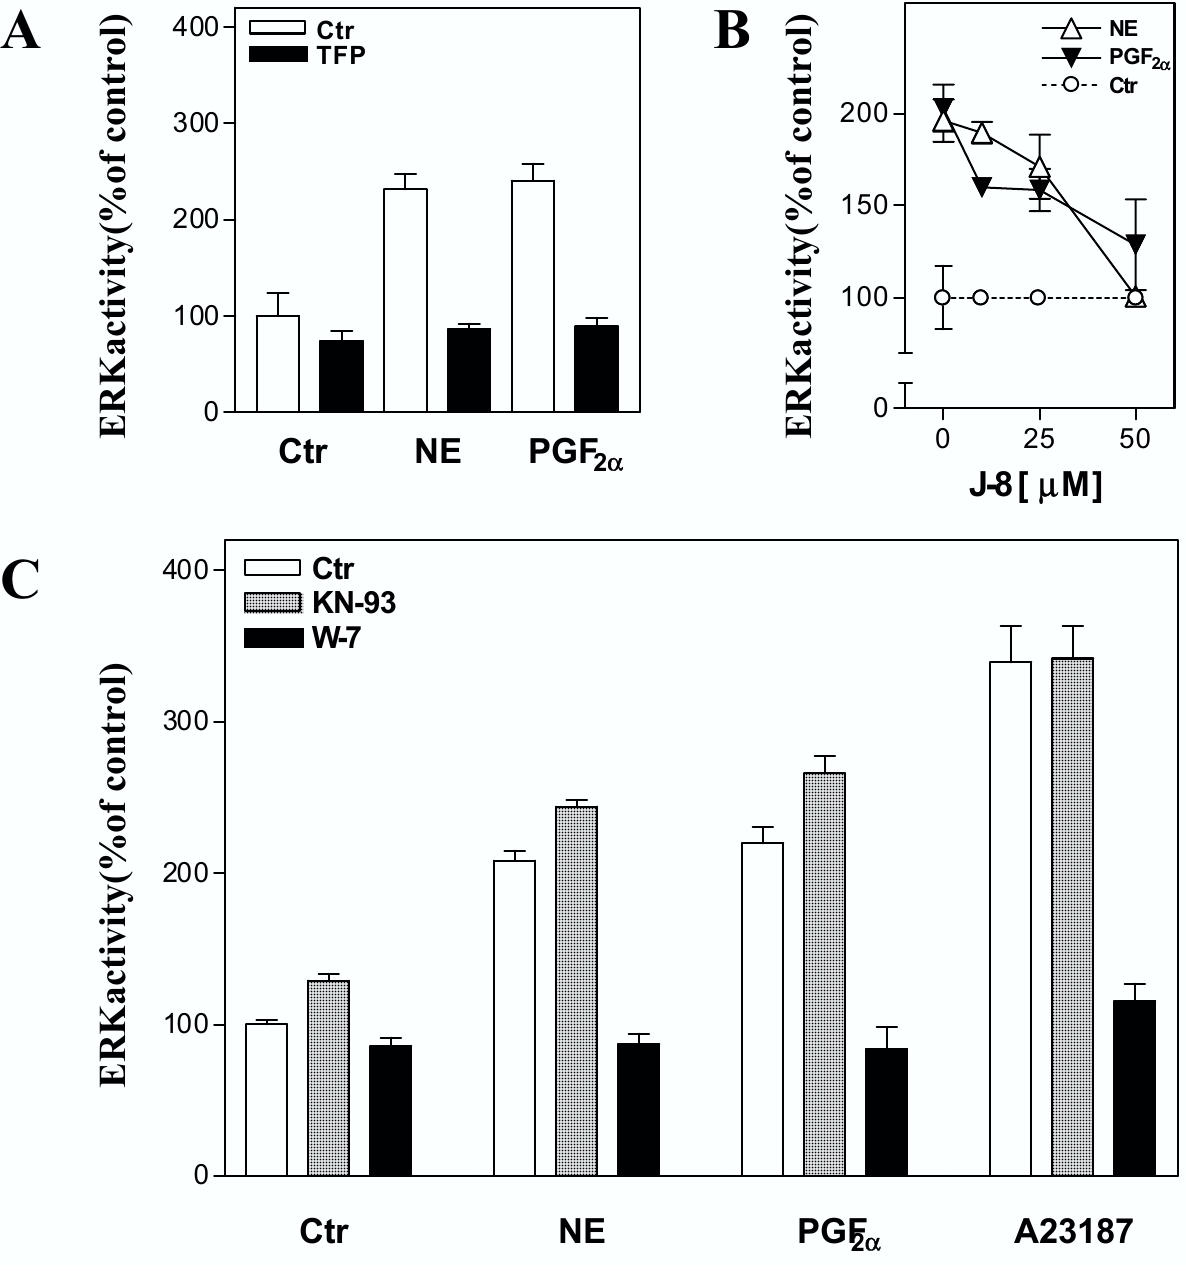
Figure 5 Effect of inhibitors of calmodulin (Trifluoperazine, J-8, W-7) and the multifunctional Ca 2+ /calmodulin dependent protein kinase (KN-93). Hepatocytes were cultured for 3 h before preincubation with timolol (10 µ M) for 30 min in the presence or absence of indicated inhibitors prior to stimulation for 5 min with norepinephrine (10 µ M), PGF 2 α (10 µ M) or A23817 (10 µ M), before cells were harvested and ERK1/2 activation assessed. A: Pretreatment with trifluoperazine (50 µ M) in 0.5 % DMSO. The results represent one typical experiment out of three and are expressed as percent of untreated control. B: Pretreatment with J-8 (10, 25, and 50 µ M) in 0.5 % DMSO. The results represent mean ± S.E.M of three experiments and are expressed as percent of cor- responding control values. C: Pretreatment with W-7 (100 µ M) or KN-93 (20 µ M) in 0.5 % DMSO, while the final DMSO con- centration during incubation with agonist was 1 %. Results represent mean ± S.E.M. of five experiments and are expressed as percent of untreated